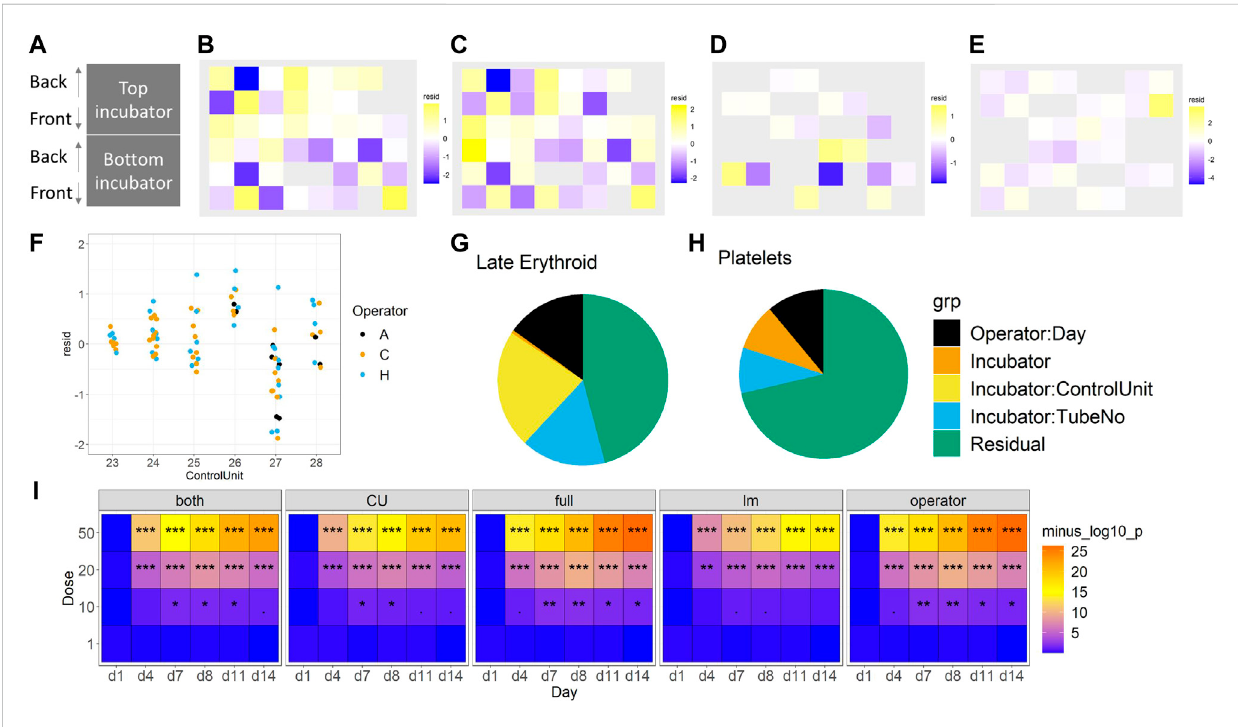
FIGURE 6 Consideration of technical effects (F vs. S). The impact of incubator position (A) on the late erythroid population (%) for BM-1 and BM-2 for fl oating (B) and (D) and scaffold (C) and (E) cells, and operator (F) . The effect of these variables on the erythroid lineage (G) and platelet lineage (H) (%) is shown. The sensitivity of the different models to toxicity ( p -value signi fi cance level) is shown in (I) . For (B – E) , purple, lower than expected; yellow, higher than expected. For I, signi fi cance values are ( < 0.1), * ( p < 0.05), ** ( p < 0.01), *** ( p <